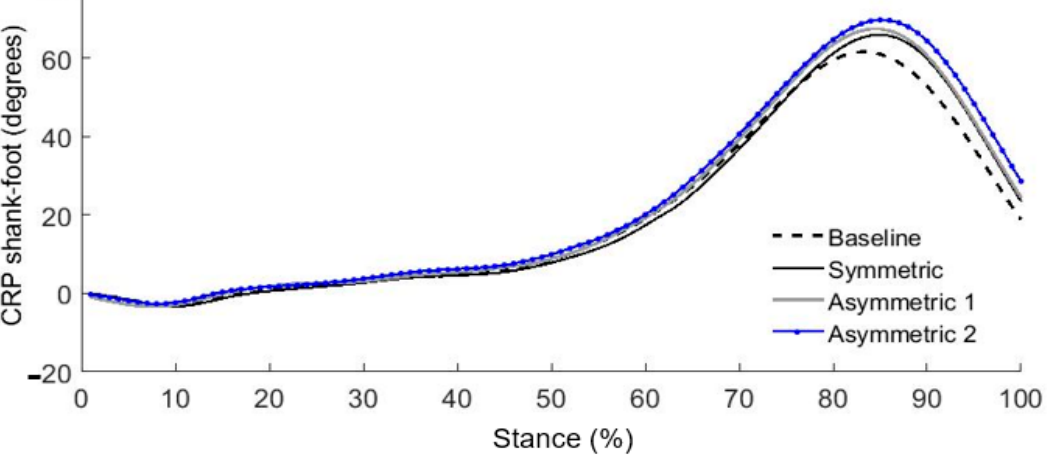
Figure 4. Mean continuous relative phase (CRP) curves in shank-foot on the loaded side during stance phase for baseline (no load) and each experimental condition (n = 25).